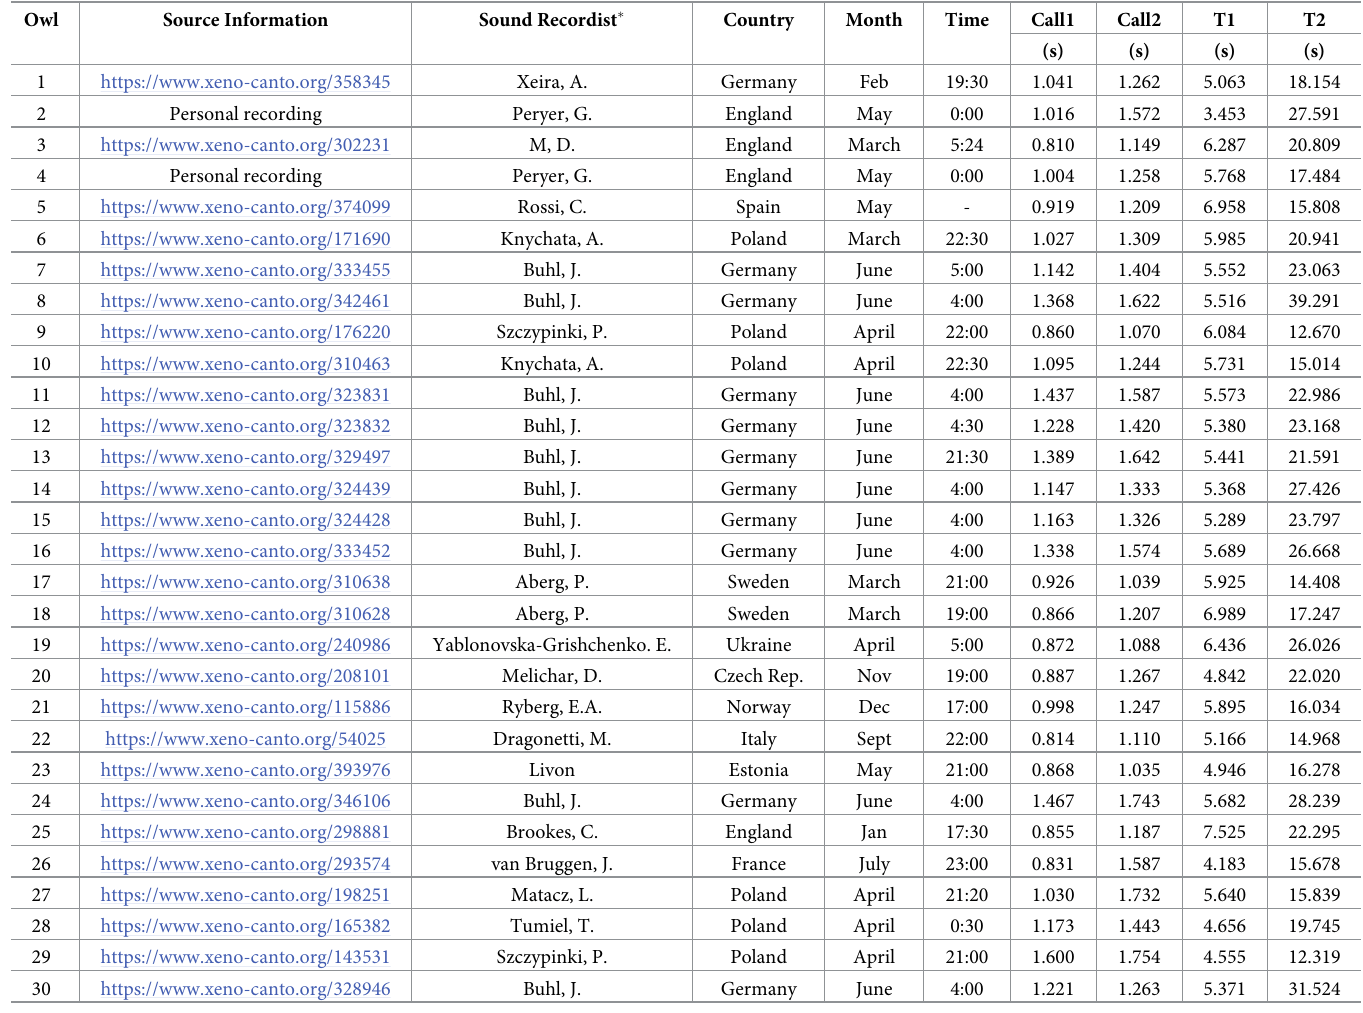
Table 1. Mean values for Strix aluco vocalization patterns analyzed in the present